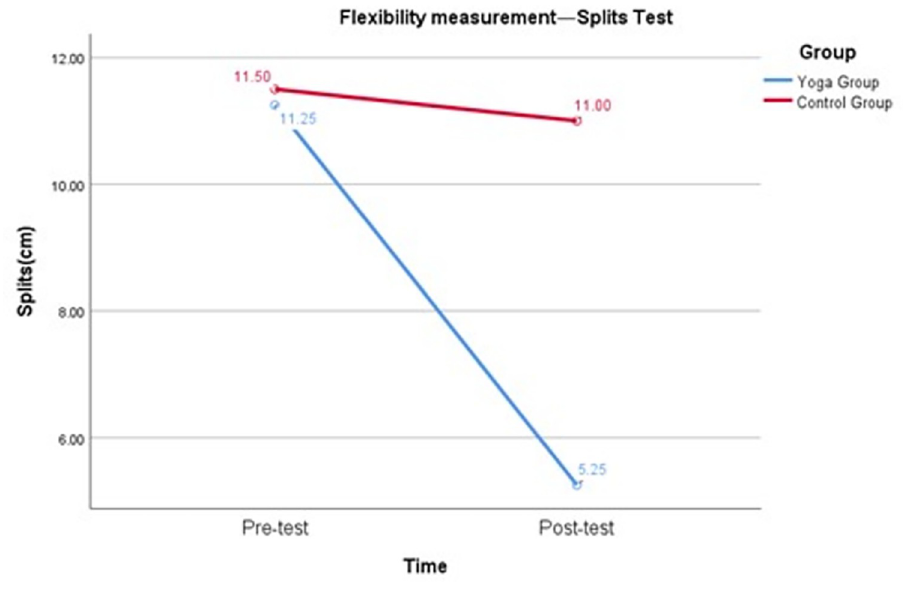
Fig 5. Flexibility measurement—Splits test.